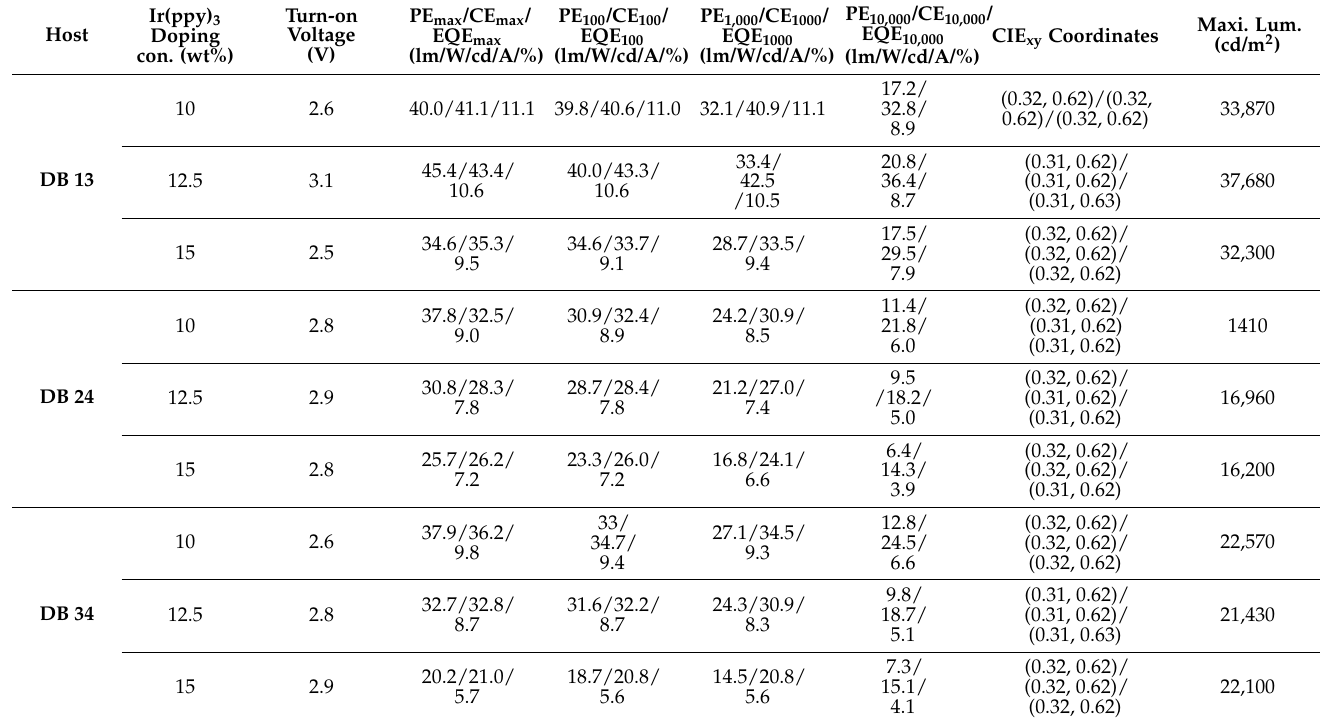
Table 3. Electroluminescent (EL) characteristics of the devices with hosts DB13, DB24, DB34, and DB43, doped with green phosphorescent emitter Ir(ppy) 3 at varying concentrations, displaying turn-on voltage, power efficacy, current efficacy, external quantum efficiency, CIE, and